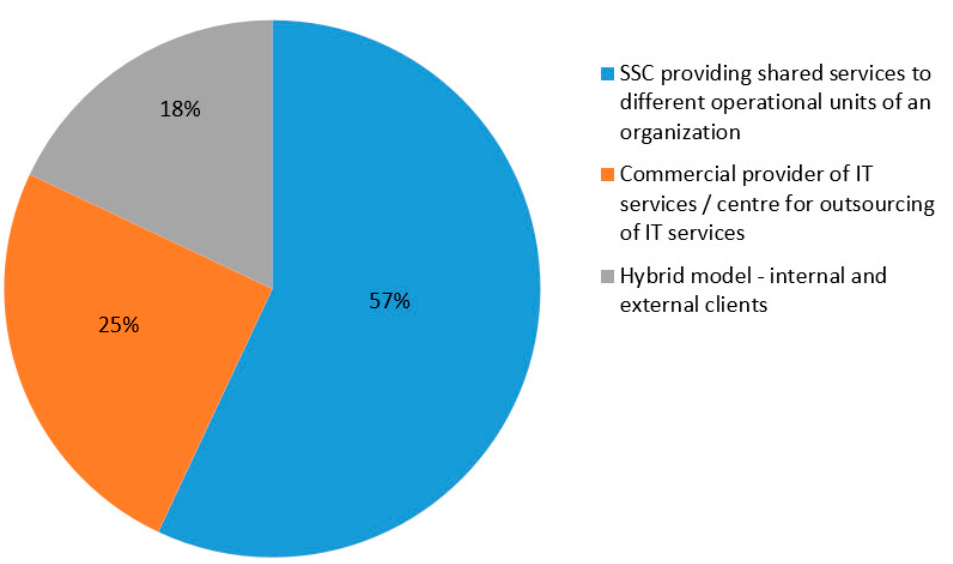
Table 3. Types and operational scope of shared services centres.